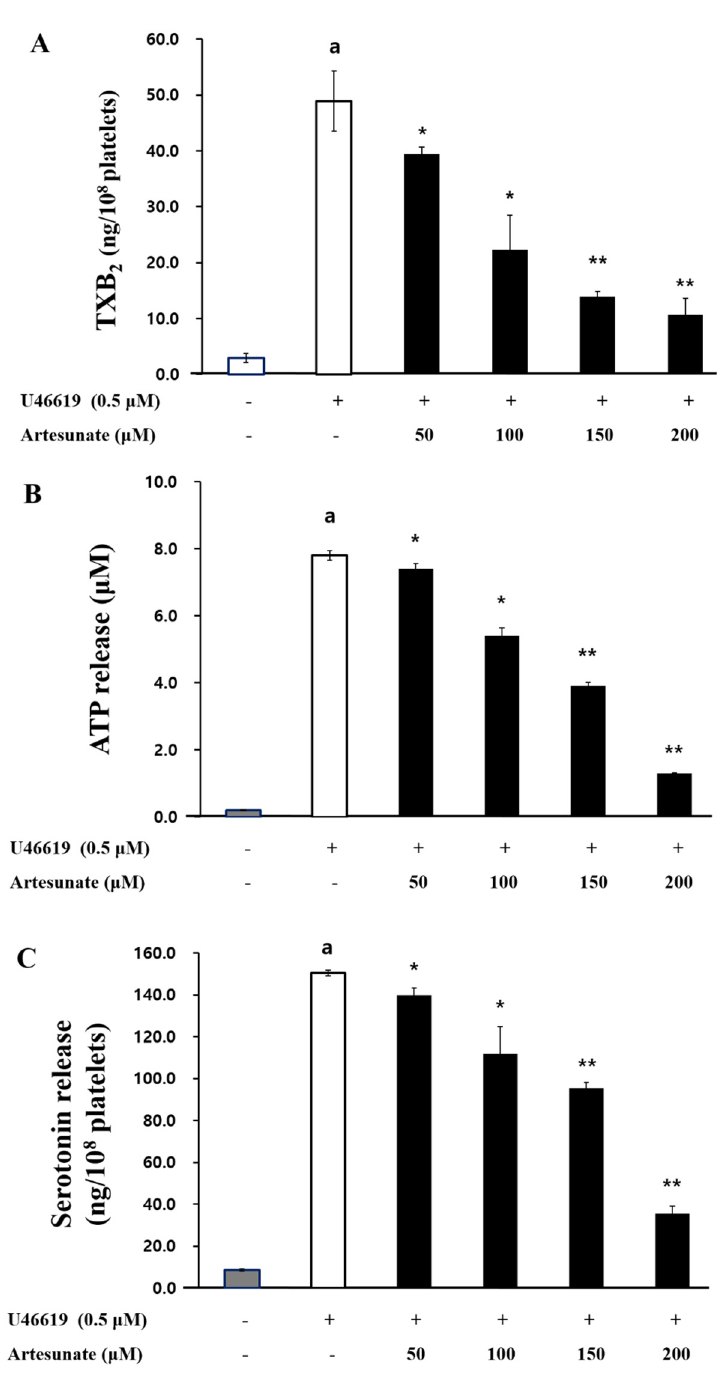
Figure 6. Artesunate’s effect on TXA 2 production and the secretion of granules. ( A ) Artesunate’s effect on TXA 2 production. ( B ) Artesunate’s effect on ATP release. ( C ) Artesunate’s effect on the release of serotonin. For 3 min, suspended platelet (10 8 cells/mL) incubation occurred at 37° with